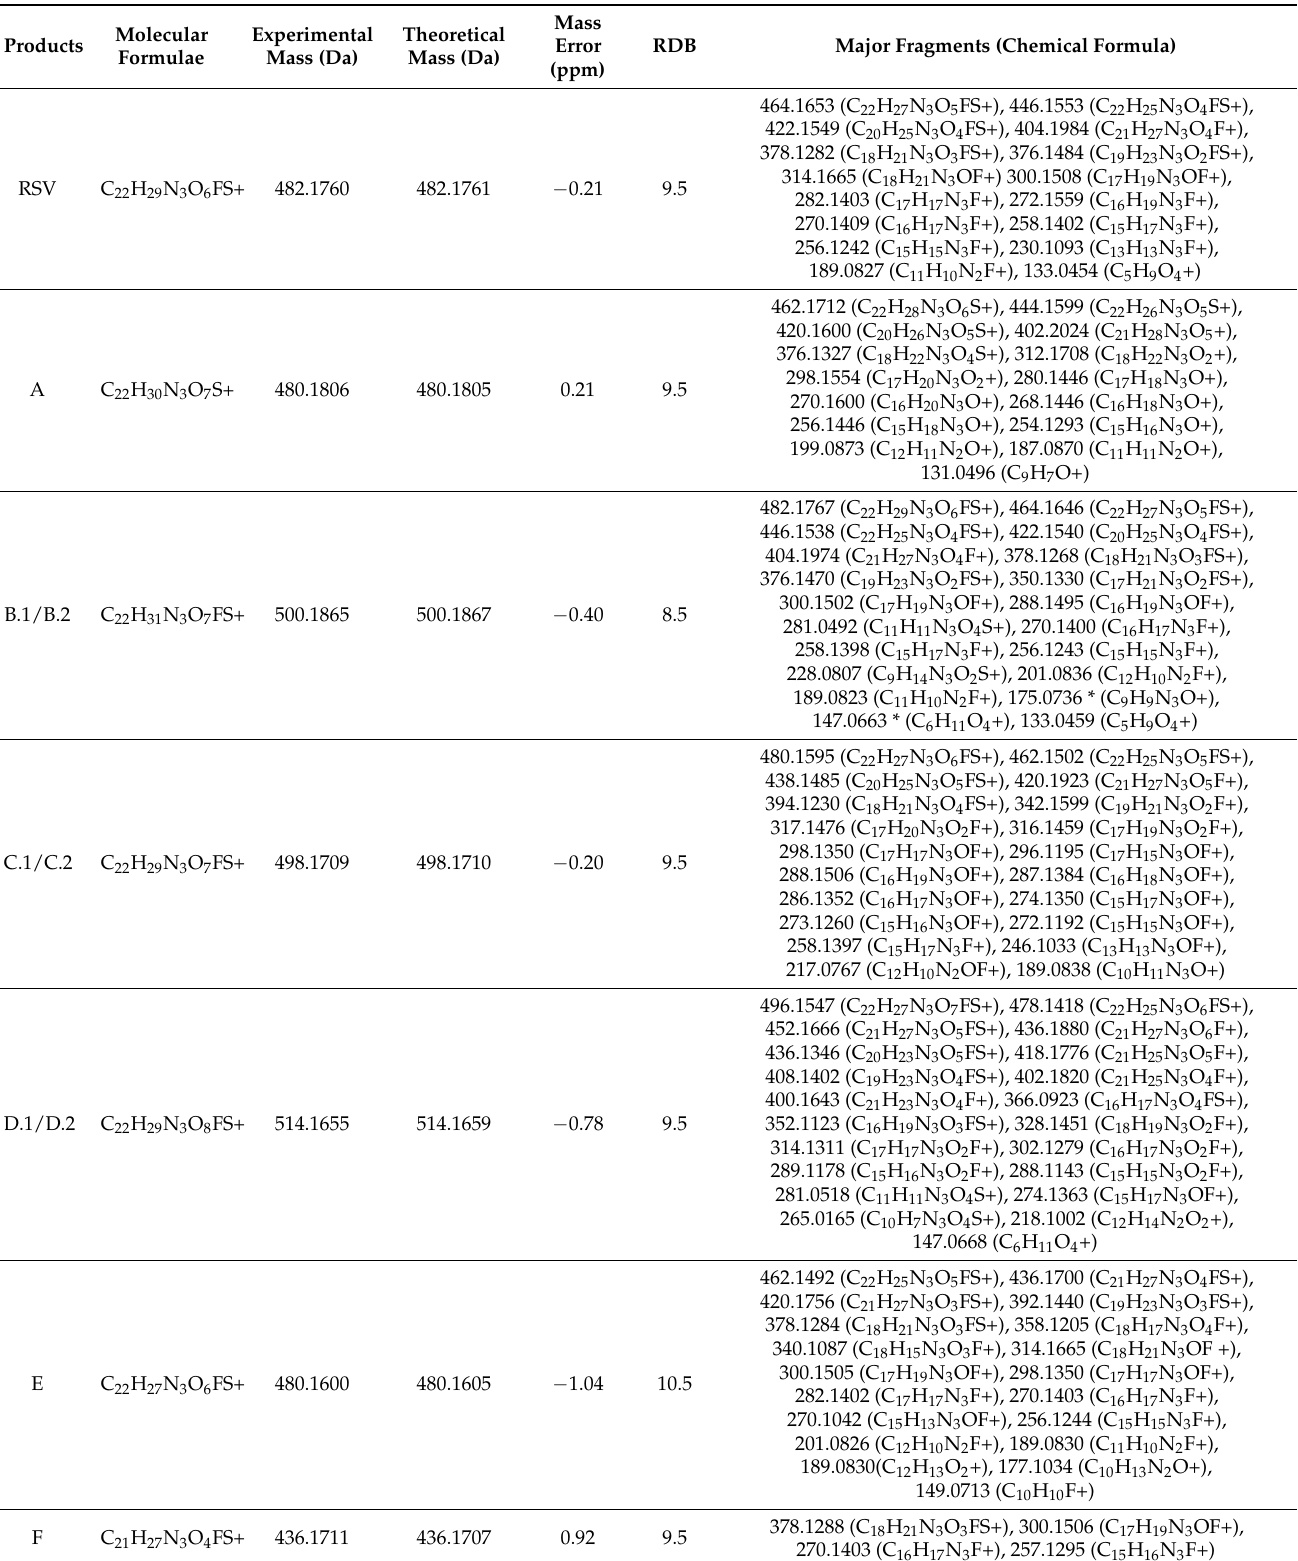
Table 1. nanoLC-nanoESI-QTOF/MS data of RSV and degradation product [M + H] + ions and corresponding MS/MS data. The asterisk is used to denote diagnostic ions present only in specific isobaric MS/MS